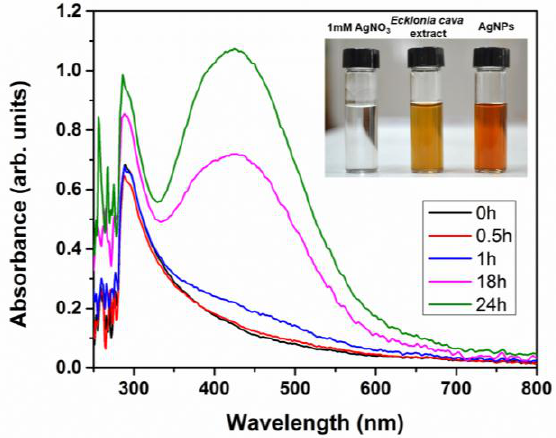
Figure 3. UV-Vis absorption spectra of biosynthesized AgNPs at different time intervals.